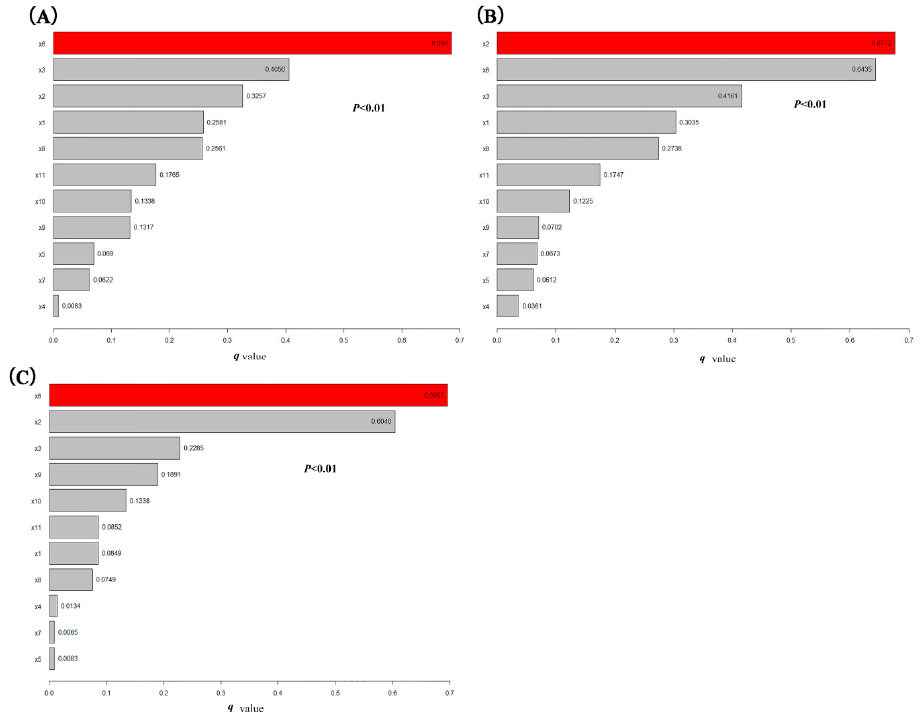
Figure 7. Results of factor detection ( A ) 2000, ( B ) 2010, and ( C ) 2020. ( p -values less than 0.001 for all factors).